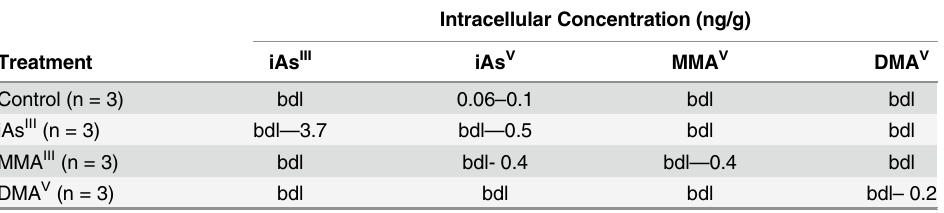
Control indicates unexposed cells. bdl = below detection limit of